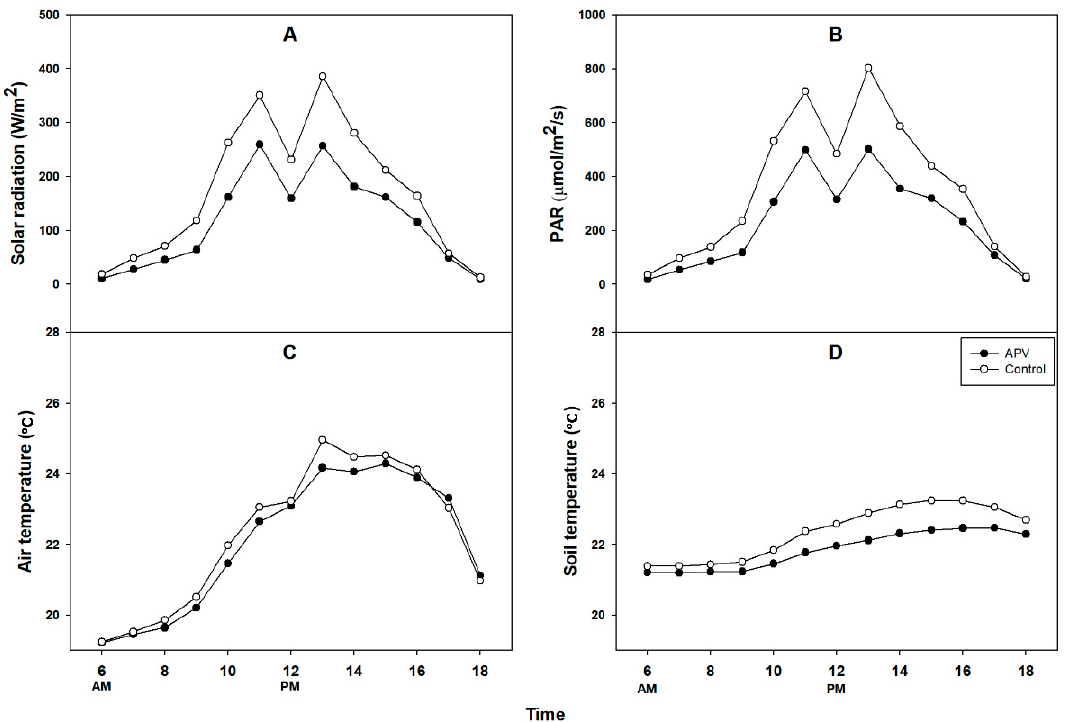
Figure 8. Solar radiation ( A ), PAR ( B ), air temperature ( C ), and soil temperature ( D ) from 6:00 to 18:00 (3 September) underneath APV system in Seungju, South Korea. In Boseong, the solar radiation from 6:00 a.m. to 6:00 p.m. (3 September 2021) was lower under the APV systems than in the control plot; the PAR was also reduced similarly (Figure 9). The greatest reduction in solar radiation under the APV system was at 1:00 p.m. (38% reduction compared to the control). The air temperature from 6:00 a.m. to 6:00 p.m. (3 September 2021) underneath the APV system in Boseong was similar to the control plot. The soil temperature was similar at both locations in the morning, but at 1:00 p.m., the control plot soil temperature was less than 1 °C higher than the soil temperatures un- der the APV system.